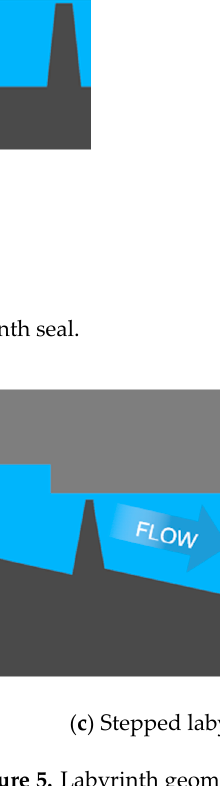
Figure 5. Labyrinth geometries examined.